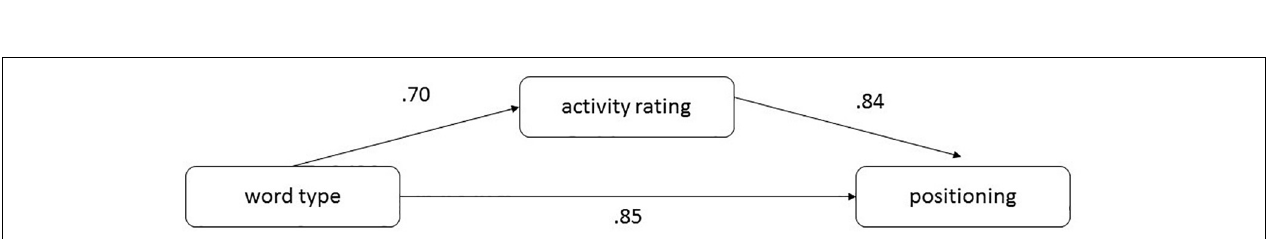
FIGURE A3 | Mediation of activity ratings on the effect of word type on positioning. Note Paths of the mediation analysis with the coefficients of the zero-order correlations.